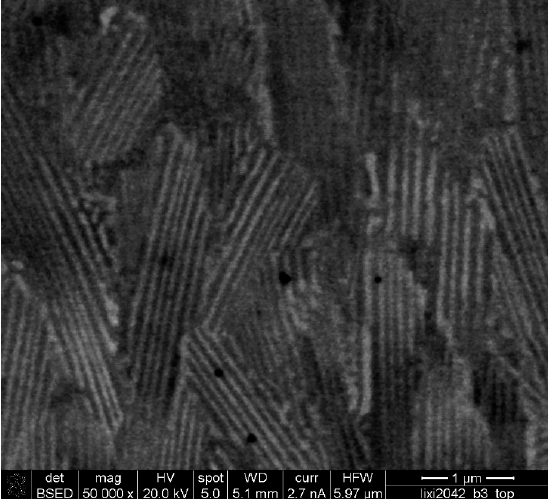
Figure 6. The microstructure of a laser coated Ni21Cr11Si showing the fine lamellar (Ni) + τ -Cr 6 Ni 16 Si 7